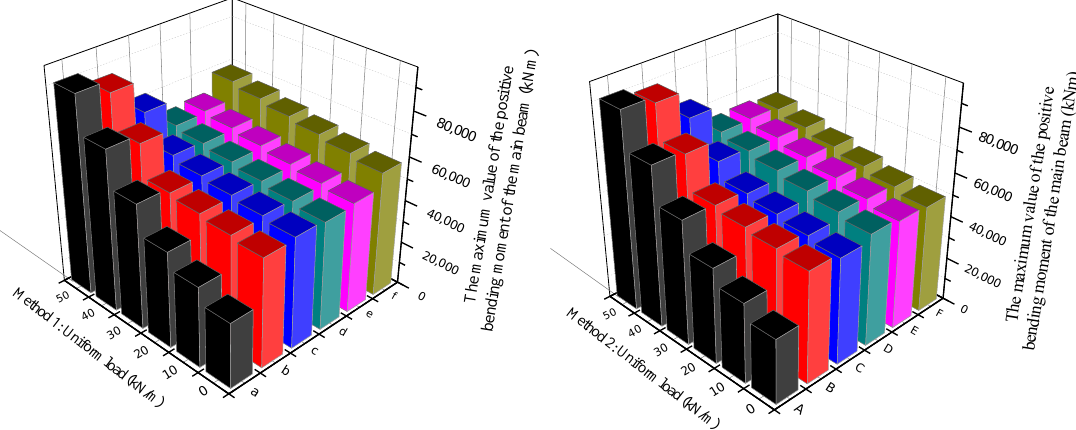
Figure 6. Comparison of maximum positive bending moment of the main beam. In the same set of six pairs of cross cables, when the unbalanced load is q = 50 kN/m, the maximum positive bending moment of the main beam in scheme d is reduced by 34.65%, and the scheme D is reduced by 29.80%. Method 1 is slightly better than method 2 for reducing the internal force of the main